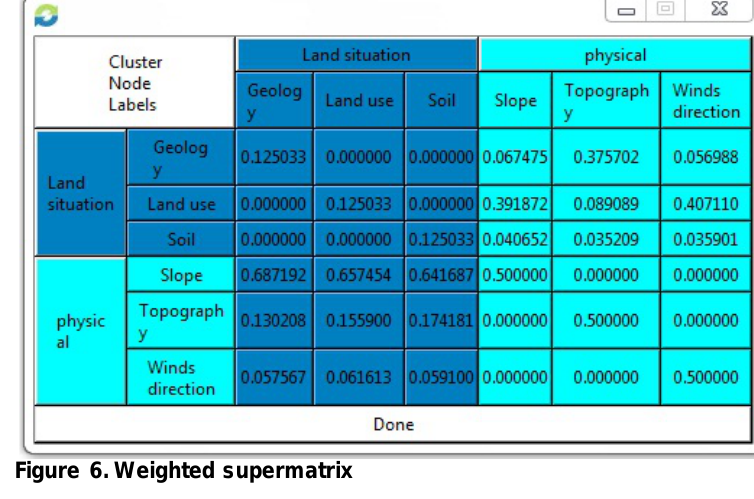
Figure 6. Weighted supermatrix